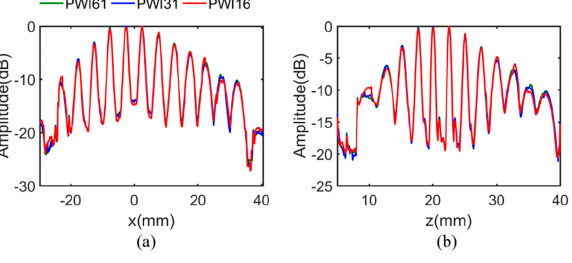
Figure 10. The projection of the maximum amplitude along the ( a ) x direction. The ( b ) z direction under the case of different plane waves number.